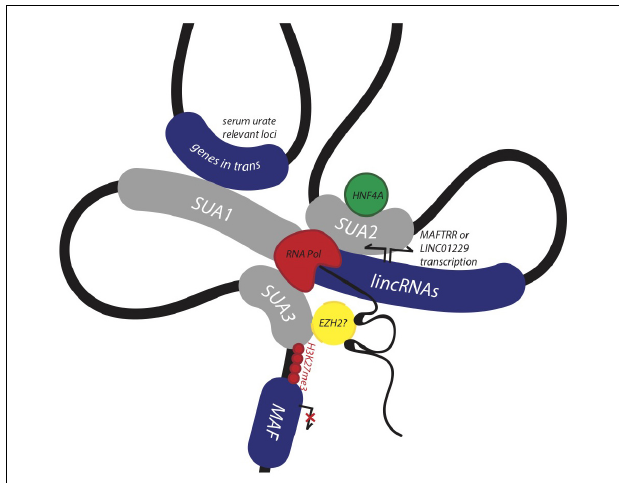
FIGURE 7 | Non-coding urate-associated variants in SUA1 and SUA2 function in a conserved genomic regulatory domain with kidney and serum urate relevant functions. The schematic depicts the proposed 3D structure at the MAF locus and upstream region encompassing SUA1, SUA2, and SUA3 as determined by Hi-C interaction data from the kidney cell line Caki2. The lincRNAs MAFTRR and LINC01229 influence expression of MAF in kidney, while serum urate-associated variants within the SUA2 kidney tubule enhancer physically connect with the lincRNA region, SUA1 and SUA3. SUA2 is bound by HNF4 α and SUA2 urate-raising variants increase the expression of LINC01229 . SUA1 is a spatially supported eQTL for MAFTRR which functions in the kidney tubule and genes in trans with serum urate relevant